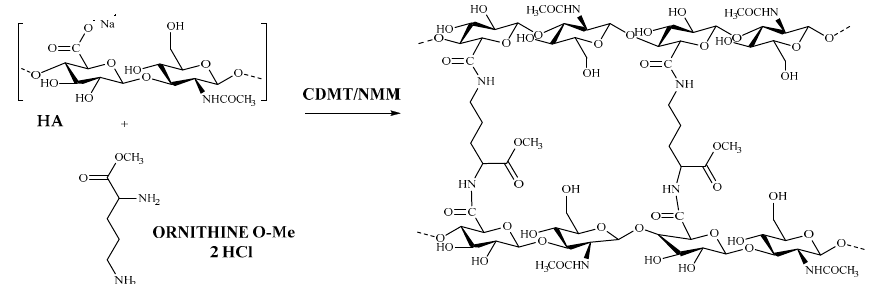
Figure 1. Synthetic scheme of HA crosslinked with the Ornithine methyl ester.